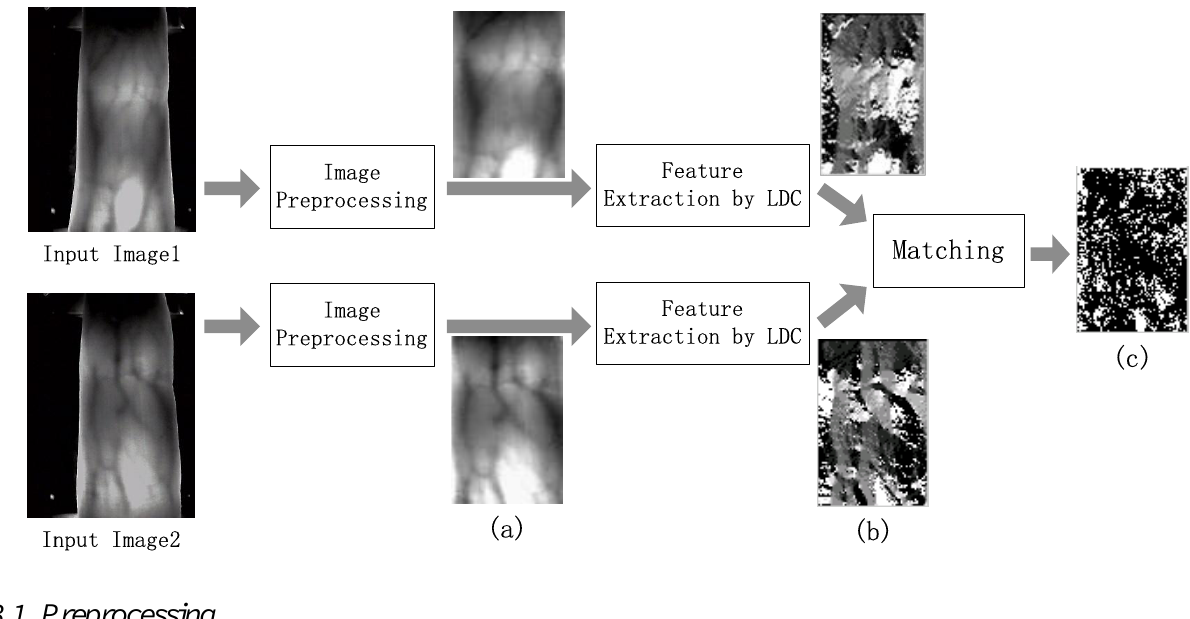
Figure 4. Flowchart of the finger vein recognition method. ( a ) Figure vein image after preprocessing; ( b ) Vision image for LDCs; ( c ) Matching results, here the black region implies the unmatched area, as Image 1 and Image 2 are from different classes, only 27 percent of the LDCs are